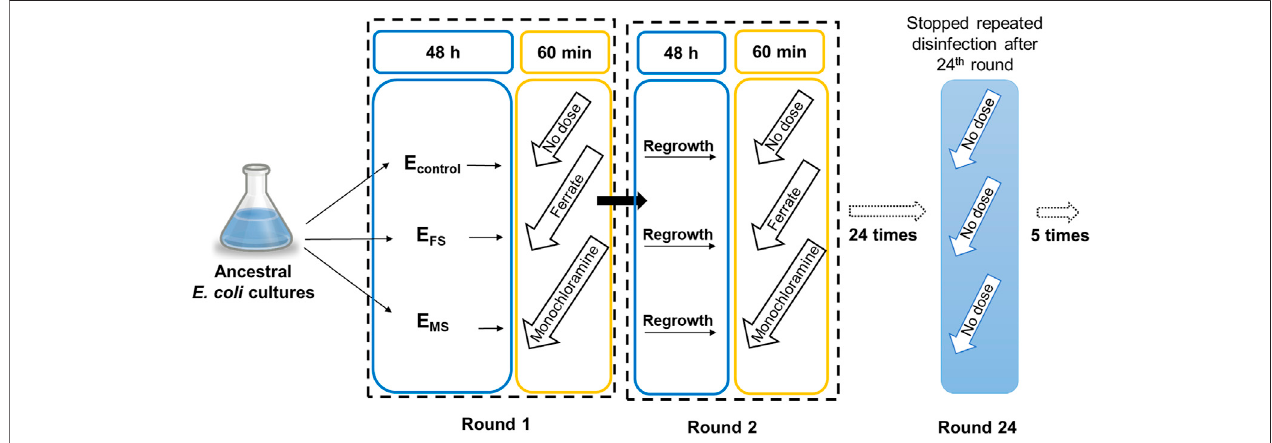
FIGURE 1 | Schematic of the experimental evolution experiment carried out to determine resistance development against disinfection. Experimental evolution of E MS , E FS , and E control under repeated monochloramine, ferrate and water treatment, respectively, every 48 h of bacterial